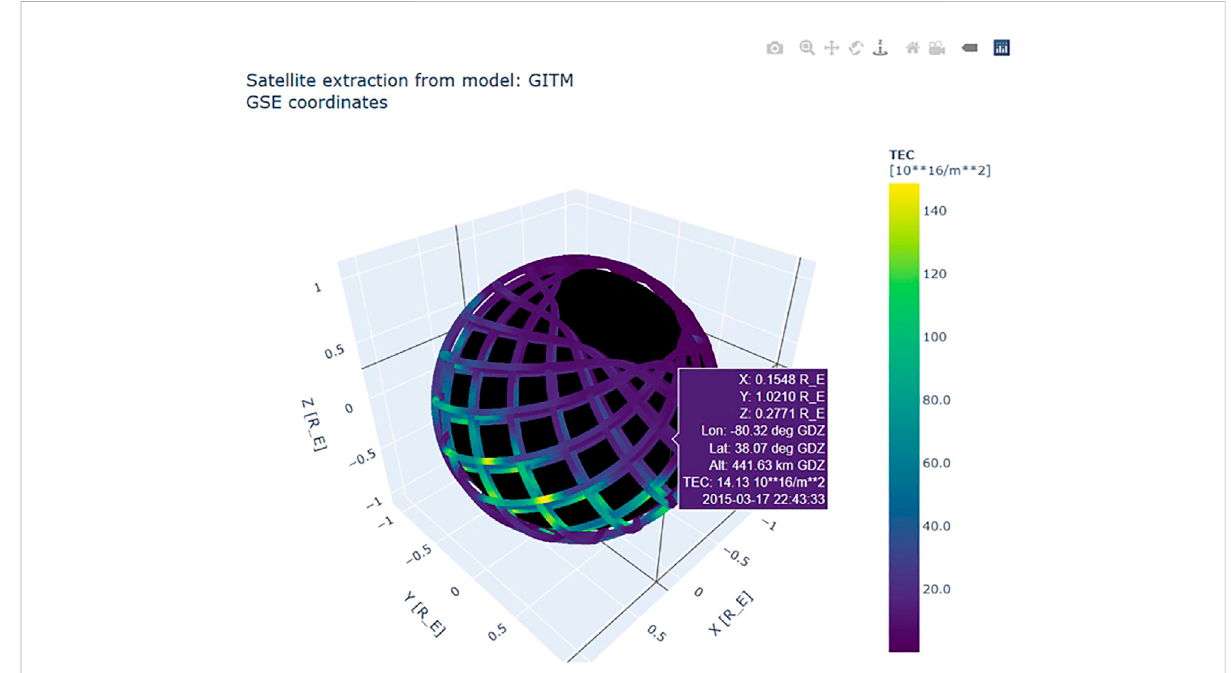
FIGURE 5 Anexampleofafullyinteractive3Dplot.Inthiscase,thetotalelectroncontent(TEC)isplottedfortheentiretyofagivensatellitetrajectory.TEC values are indicated by the colorbar at right, and the model source and coordinate system are printed in the top left corner. The purple box contains thecoordinateinformationinGSEcoordinates,bothinCartesianandspherical,theTECvalue,alsoindicatedbythecolorofthebox,andthedateand time in UTC for the data point hovered over by the mouse. The symbols on the top right are the typical buttons provided by Plotly. The plot is saved as a fully interactive html fi le. An example is included on the NASA Kamodo repository 5